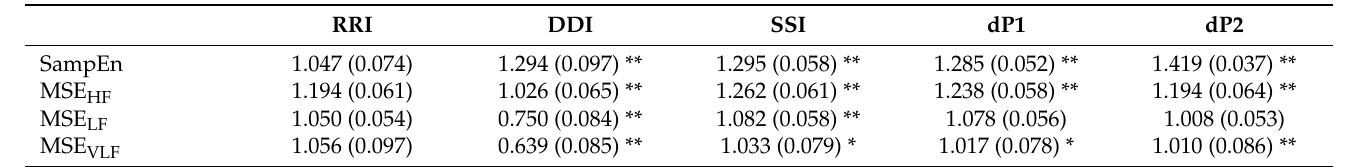
Table A1. Entropy indexes for embedding dimension m = 2 in N = 21 participants sleeping at high altitude: median (SE median) by type of